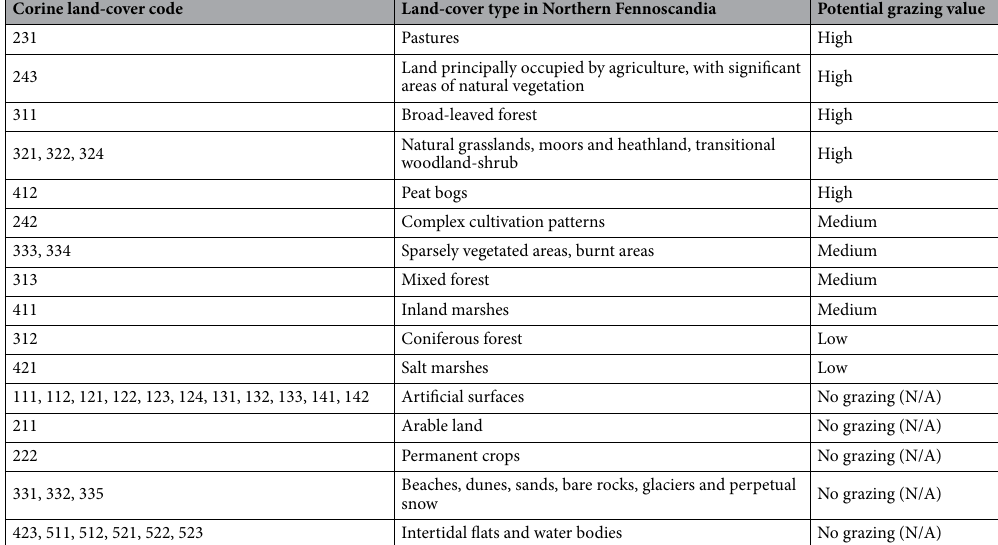
weather, data from 30-year periods or more are commonly used 53 . Here we selected the two last 30-year periods